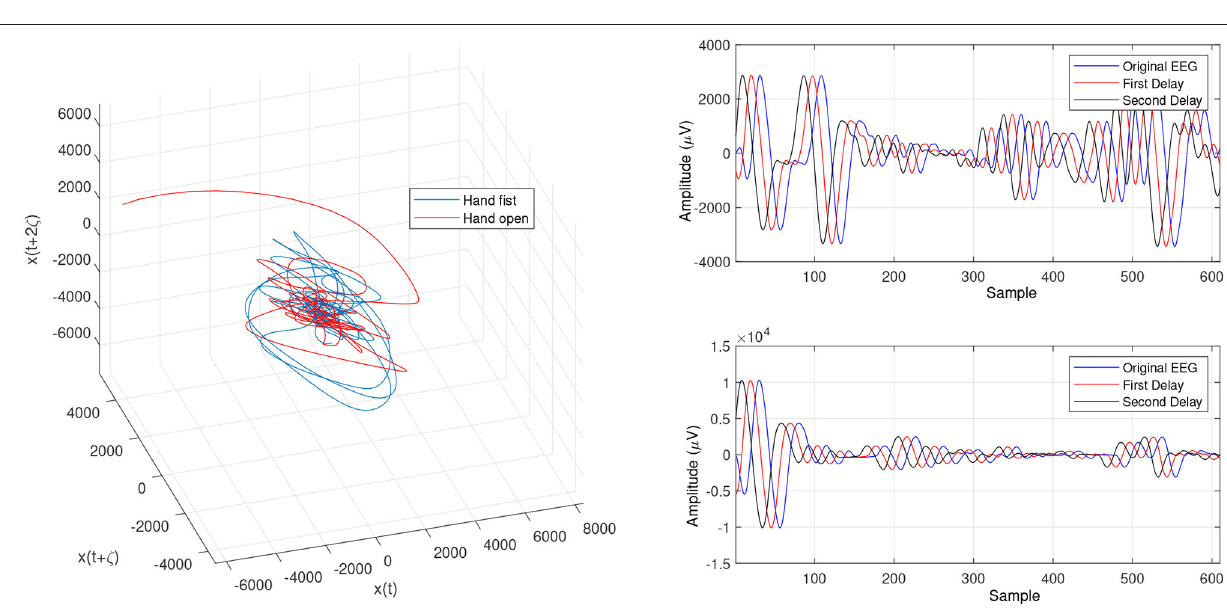
FIGURE 7 | Trajectories of an open hand and making a fist using the OLLE in the reconstructed phase space based on the WD for channel